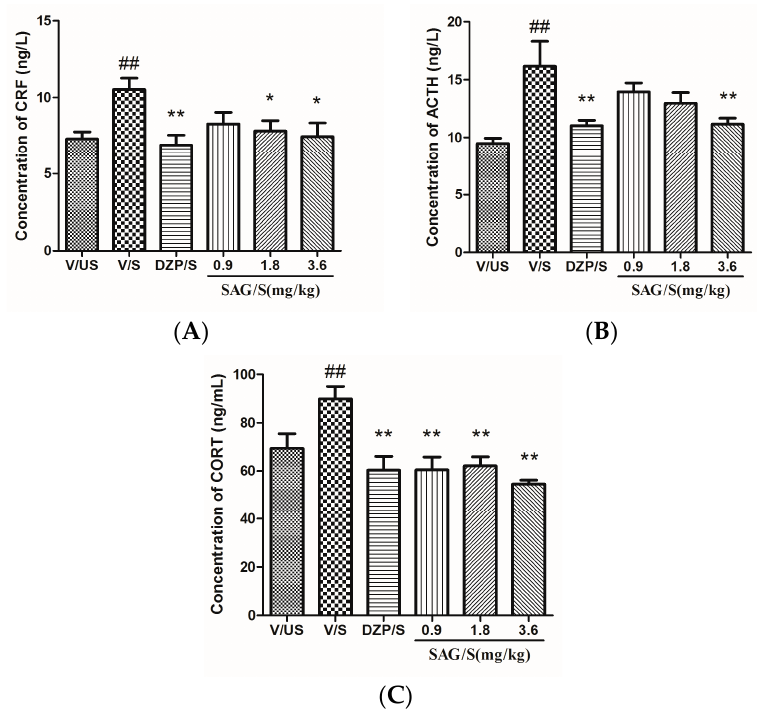
Figure 3. Effect of SAG (0.9, 1.8, 3.6 mg/kg) on serum CRF, ACTH and CORT levels after the behavior tests. ( A ) Concentration of CRF (ng/L); ( B ) Concentration of ACTH (ng/L); ( C ) Concentration of CORT (ng/mL). Bars represent mean ± SEM. ## p < 0.01 vs. vehicle/unstressed group; * p < 0.05 or ** p < 0.01 vs. vehicle/stressed group. One-way ANOVA with Student-Newman-Keuls post hoc test.